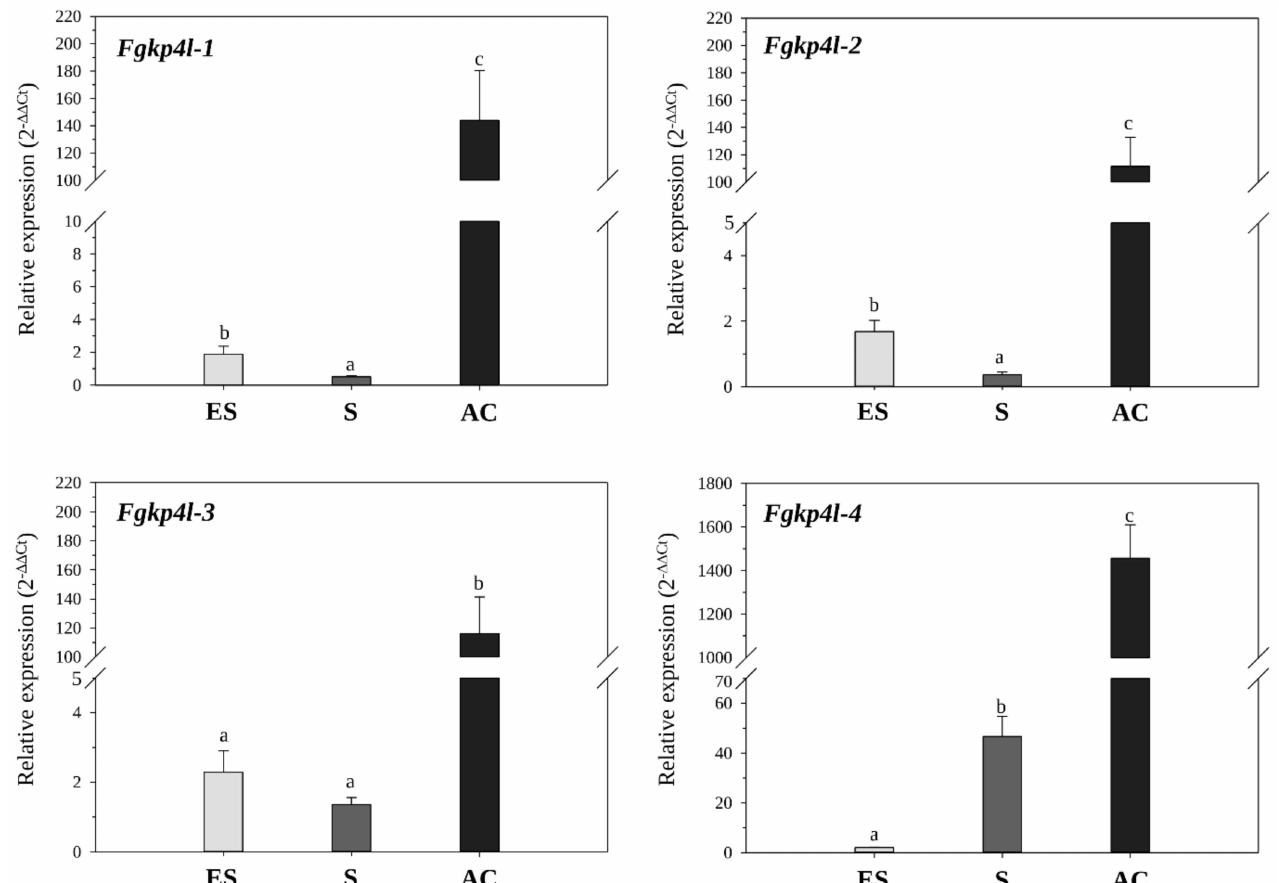
Figure 2. Expression profiles of each Fgkp4l gene during the three phases of interaction with T. gamsii . The bars represent means of three biological replicates with the corresponding standard deviation of values from the non-self-interaction condition obtained during three different sampling points: early-sensing phase (ES), 15 mm of distance between fungal colonies; sensing phase (S), 5–8 mm of the distance between colonies; after-contact phase (AC), 24 h overgrowth. The different letters correspond to statistically different values for p ≤ 0.05 (ANOVA and Tukey’s